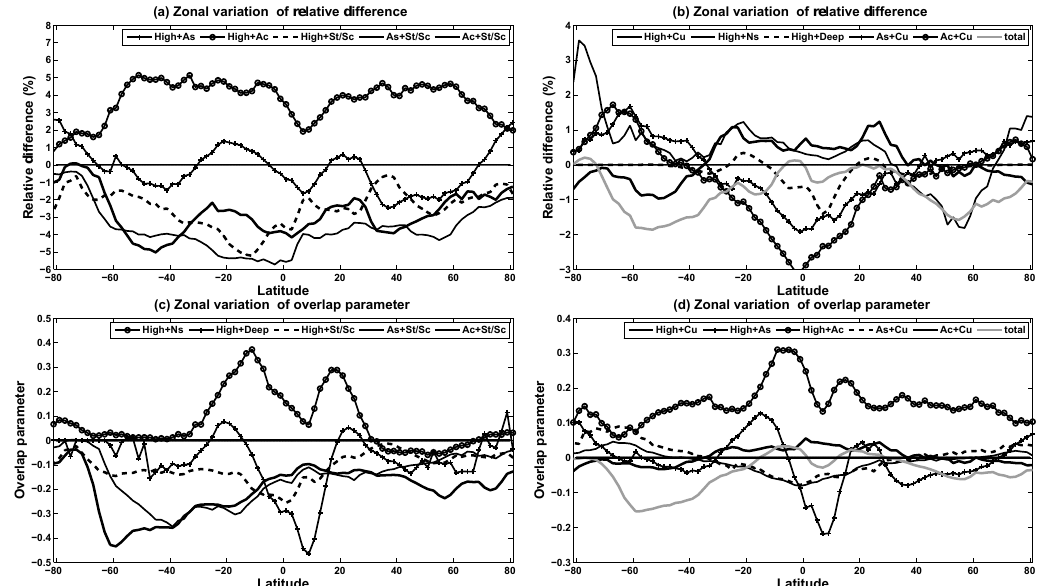
Figure 8. (a, b) The zonal distributions of the relative difference between the random and actual overlap for different multilayered cloud types and the cumulative relative difference of all multilayered cloud types (gray line). (c, d) The zonal distributions of the overlap parameter for different multilayered cloud types and the cumulative overlap parameter of all multilayered cloud types (gray